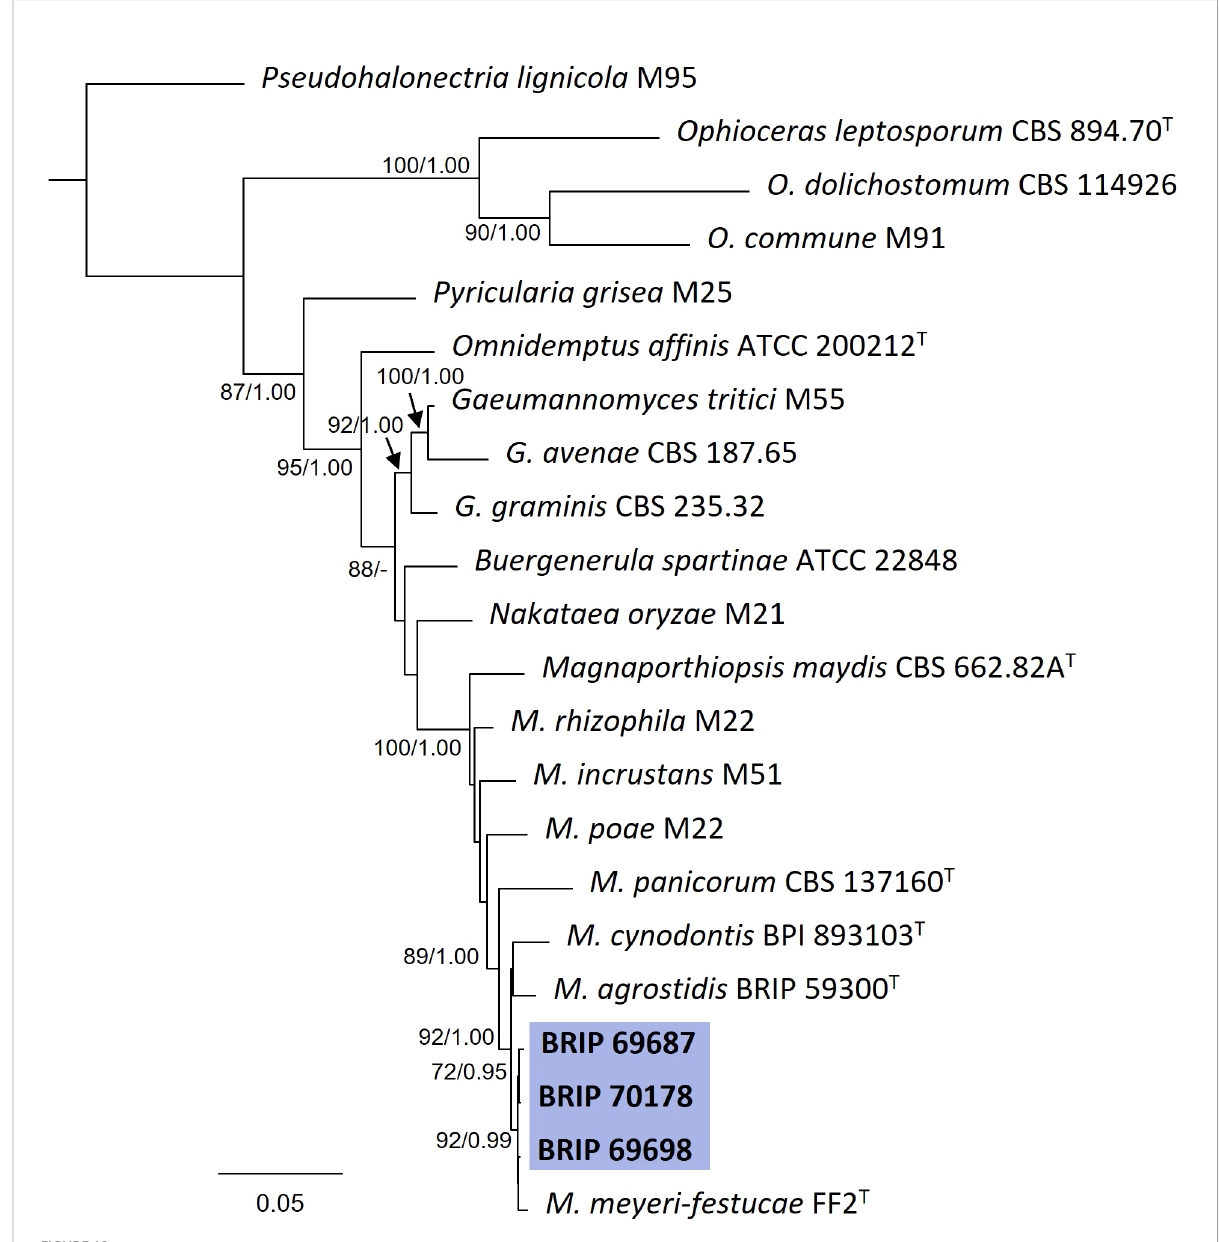
FIGURE 12 Phylogenetic tree inferred from a RAxML analysis based on a concatenated alignment of ITS, LSU, SSU and tef1- a sequences of related genera from Magnaporthaceae (Magnaporthiales). RAxML bootstrap (bs) values greater than 70% and Bayesian posterior probabilities (pp) greater than 0.8 are given at the nodes (bs/pp). In bold font are the isolates from this study, and ex-type strains are indicated with T